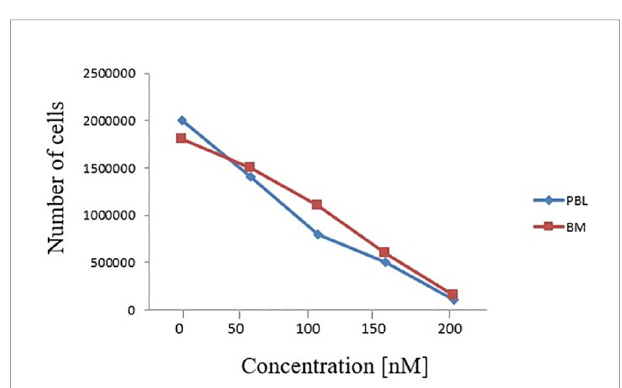
FIGURE 4 | Effects of increasing doses of midostaurin on the clonogenic capacity of primary BM and PBL cells carrying the reported FLT3 deletion (c.1770_1784del15;